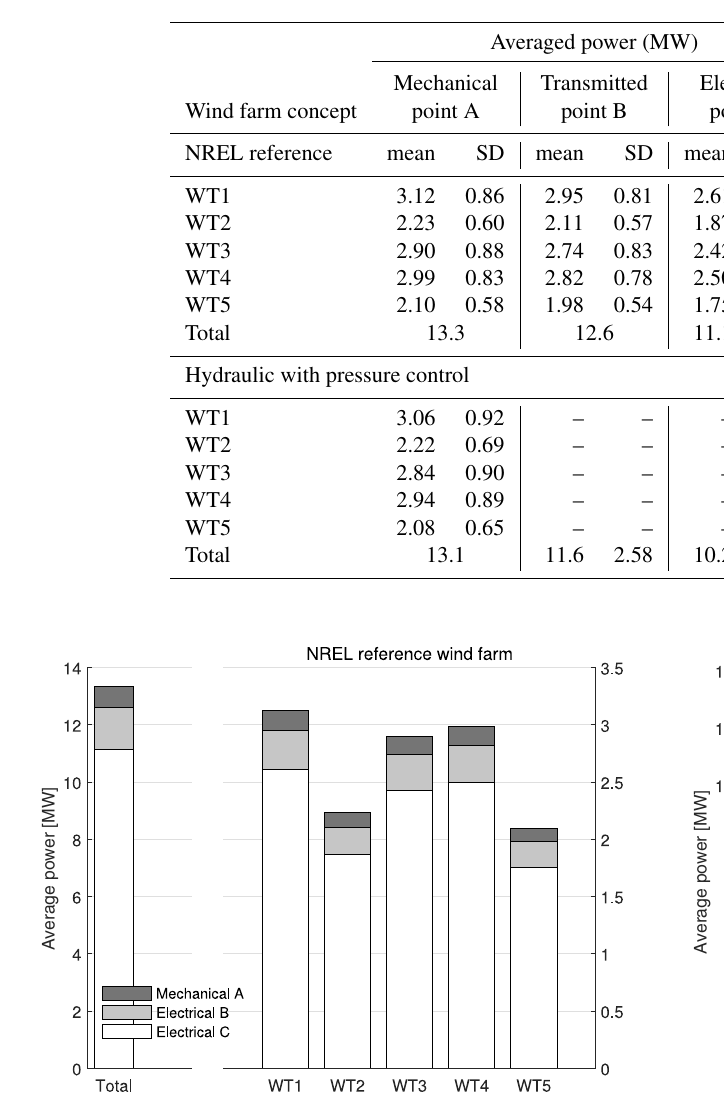
Figure 14. Power performance for the reference wind farm, below rated conditions.